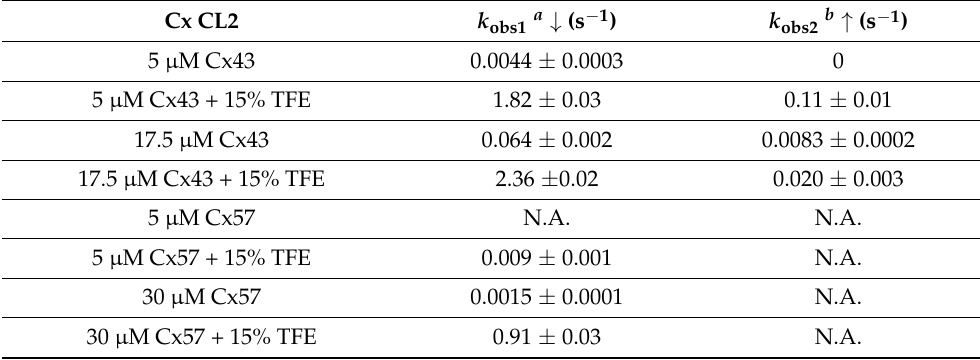
Figure 4. Association and dissociation kinetics of apo-DA-CaM and ( A , B ) Cx32 CL2, ( C , D ) Cx43 CL2, ( E , F ) Cx45 CL2, ( G ) Cx57 CL2 (with and without 15% TFE) and ( H ) Cx43 CL2 (with and without 15% TFE) peptides, respectively. Table 4. The effect of TFE on the on-kinetics of Cx43 and Cx57 CL2